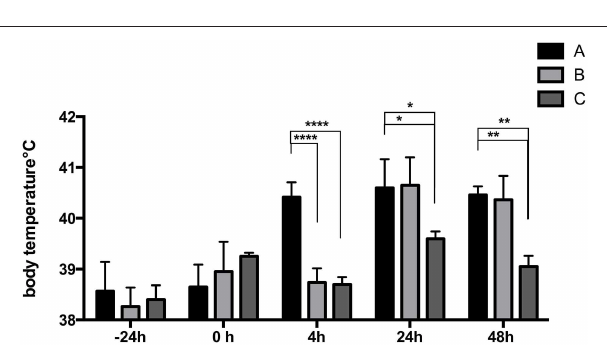
FIGURE 3 | LPS-treatment of piglets induces a rise in body temperature 4h after infection with STM14028. The body temperature was measured at different time points on three different groups of piglets: treated with LPS and infected with STM14028 (group A); only STM14028 infected (group B); naïve control group (group C). At 4h post infection, group A showed a significant rise in body temperature compared to the B and C groups. Data refer to one out of two separate experiments performed with comparable results. The differences between groups were statistically significant ( **** P ≤ 0.0001 ; * P ≤ 0.1 ; ** P ≤ 0.01 multiple comparisons-Fisher’s Least Significant Difference